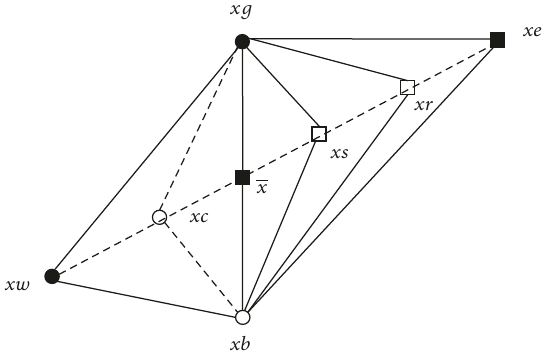
Figure 3: Simplex method to search for different